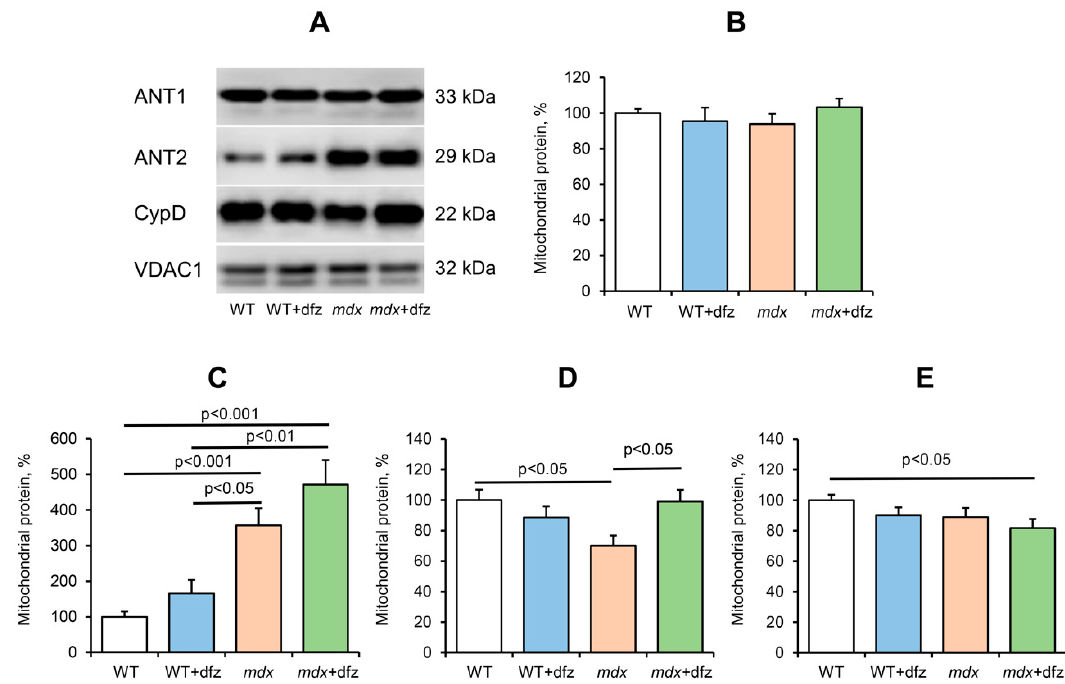
Figure 8. Levels of putative components of the MPT pore in the skeletal-muscle mitochondria of the studied groups of mice. Data of Western blot analysis ( A ). Relative contents of MPT-related proteins: ANT1 ( B ), ANT2 ( C ), CypD ( D ), VDAC1 ( E ). The data are presented as means ± SEM ( n = 6).